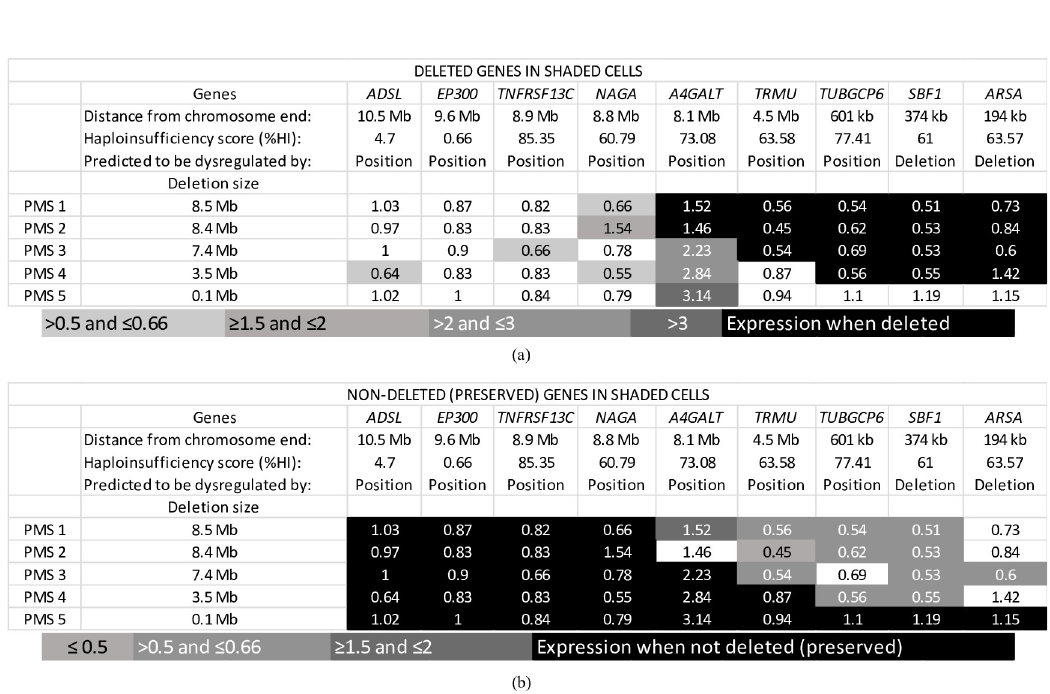
Fig 4. (a) Heat map of expression of genes in five individuals relative to control with deleted genes in gray cells. (b) Heat map of expression of genes in the five individuals relative to control with pre genes in gray cells. Numbers are relative fold changes in expression (2- ΔΔ Ct). These heat maps give an account of exactly the same data displayed with two different shading schemes, expression differences due to dysregulation by position effects in (a) and by deletion in (b). The third row in both show causes of dysregulation predicted for each gene by position effect analysis as either dysregulated by position effect or by deletion.